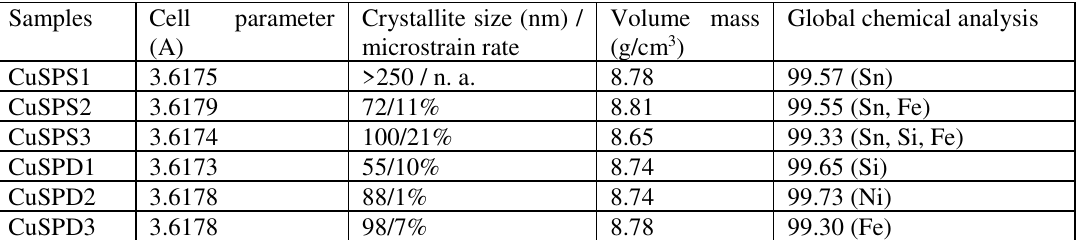
Table 2 . Chemical composition (XRF) and phase analysis